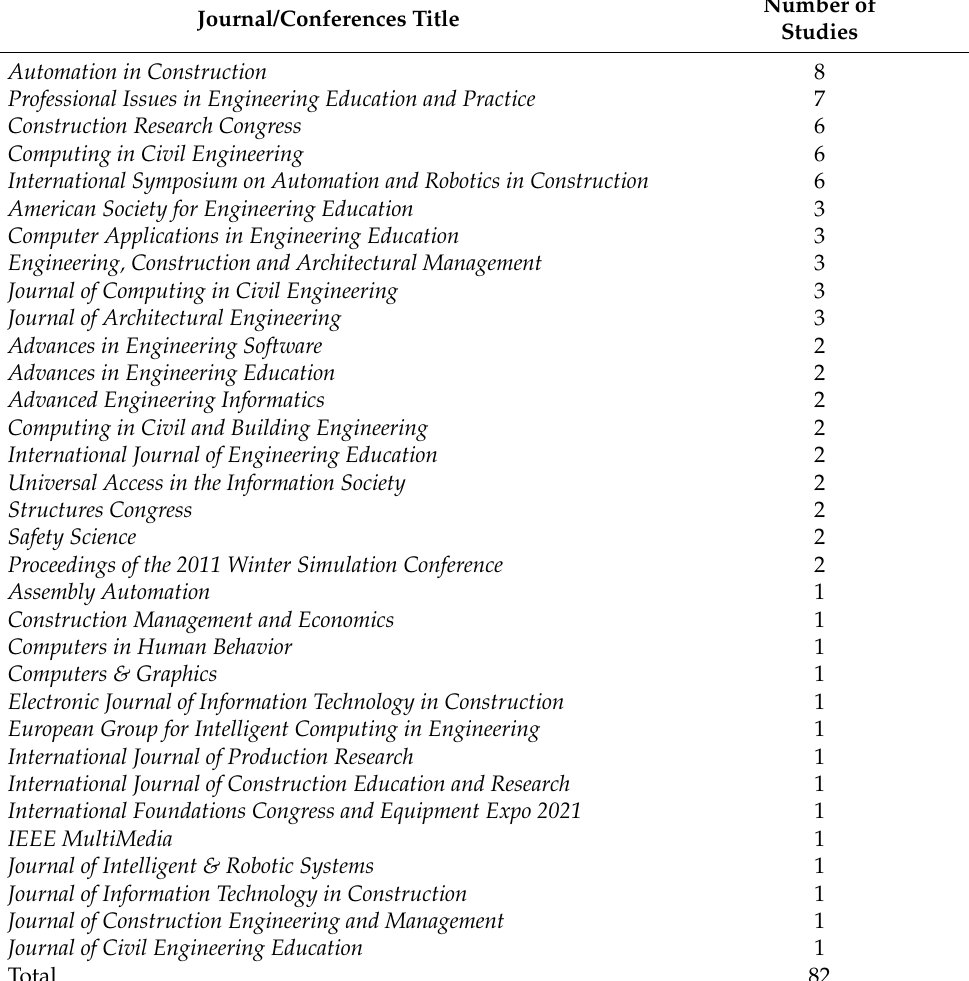
Table 1. List of journals and conferences of 82